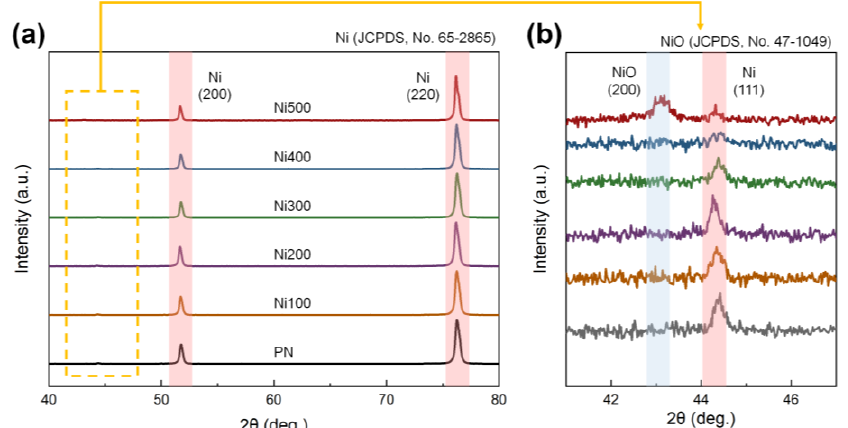
Figure 4. ( a ) XRD diffraction patterns of PN, Ni100, Ni200, Ni300, Ni400, and Ni500 in the range of 40–80 ◦ . ( b ) Magnification of the XRD diffraction patterns in the range of 41–47 ◦ . The red and blue lines in each figure indicate the leading peaks of Ni and NiO,